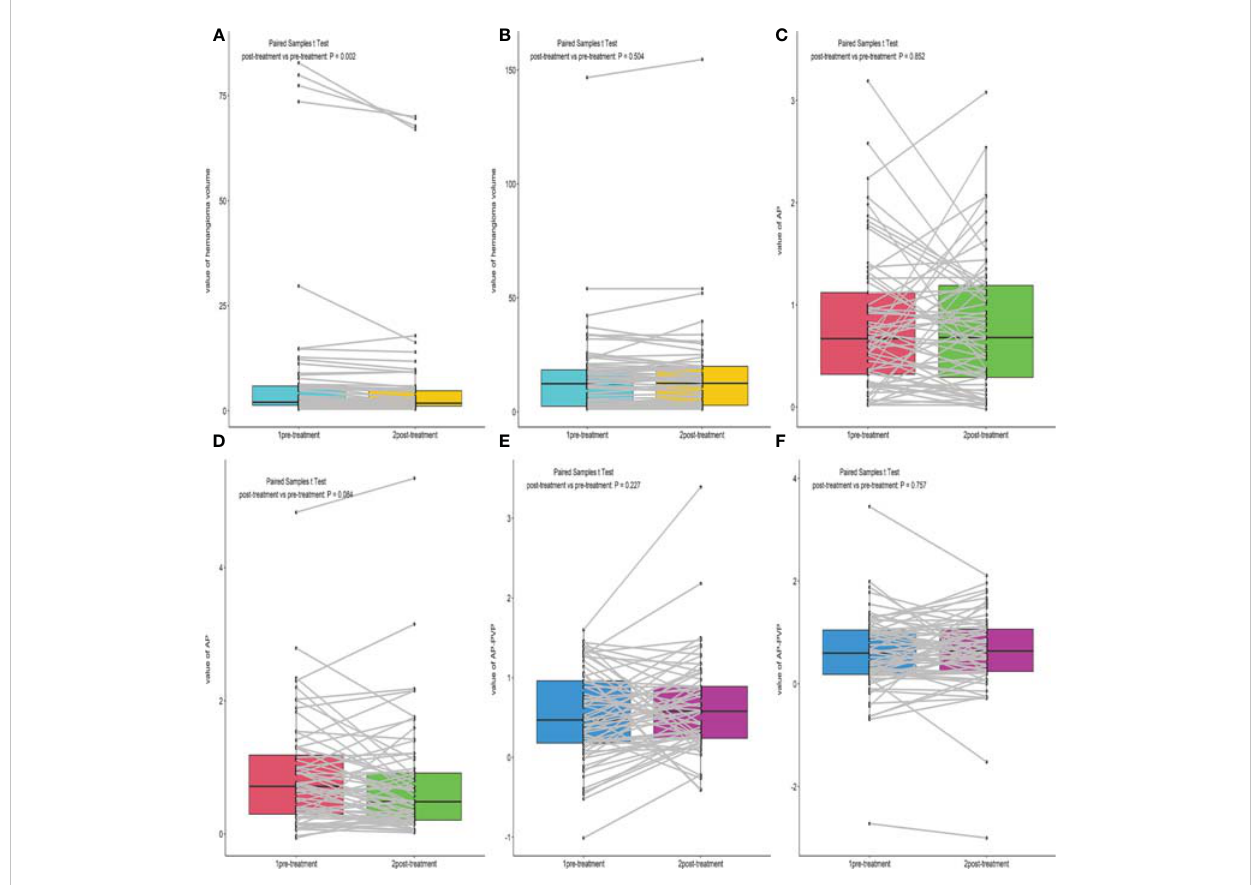
FIGURE 2 Box plot of the Hemangioma volume, AP, AP-PVP before and after treatment. (A, B) Comparison of hemangioma volume before and after treatment of the Bevacizumab and Control group. (C – F) Comparison of hemangioma AP, AP-PVP before and after treatment of the Bevacizumab and Control